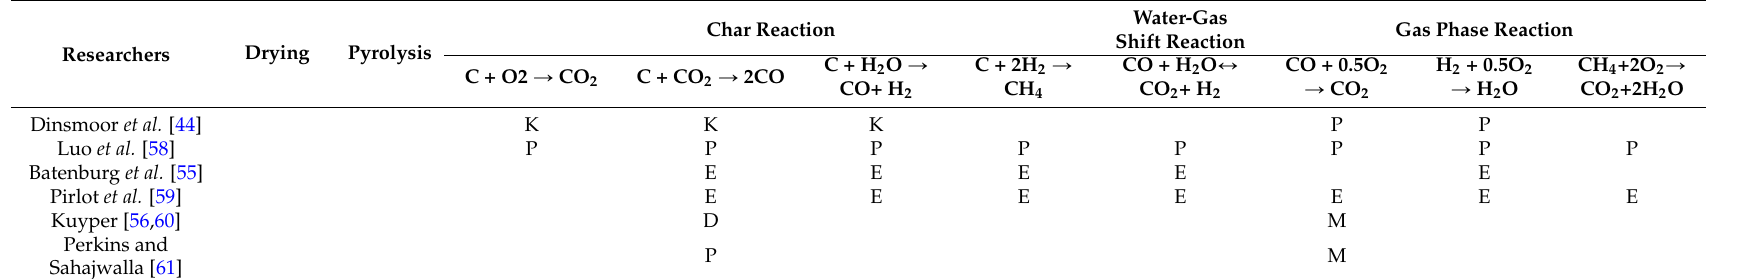
Table 15. Reaction rate control mechanisms of the main reactions in the gasification